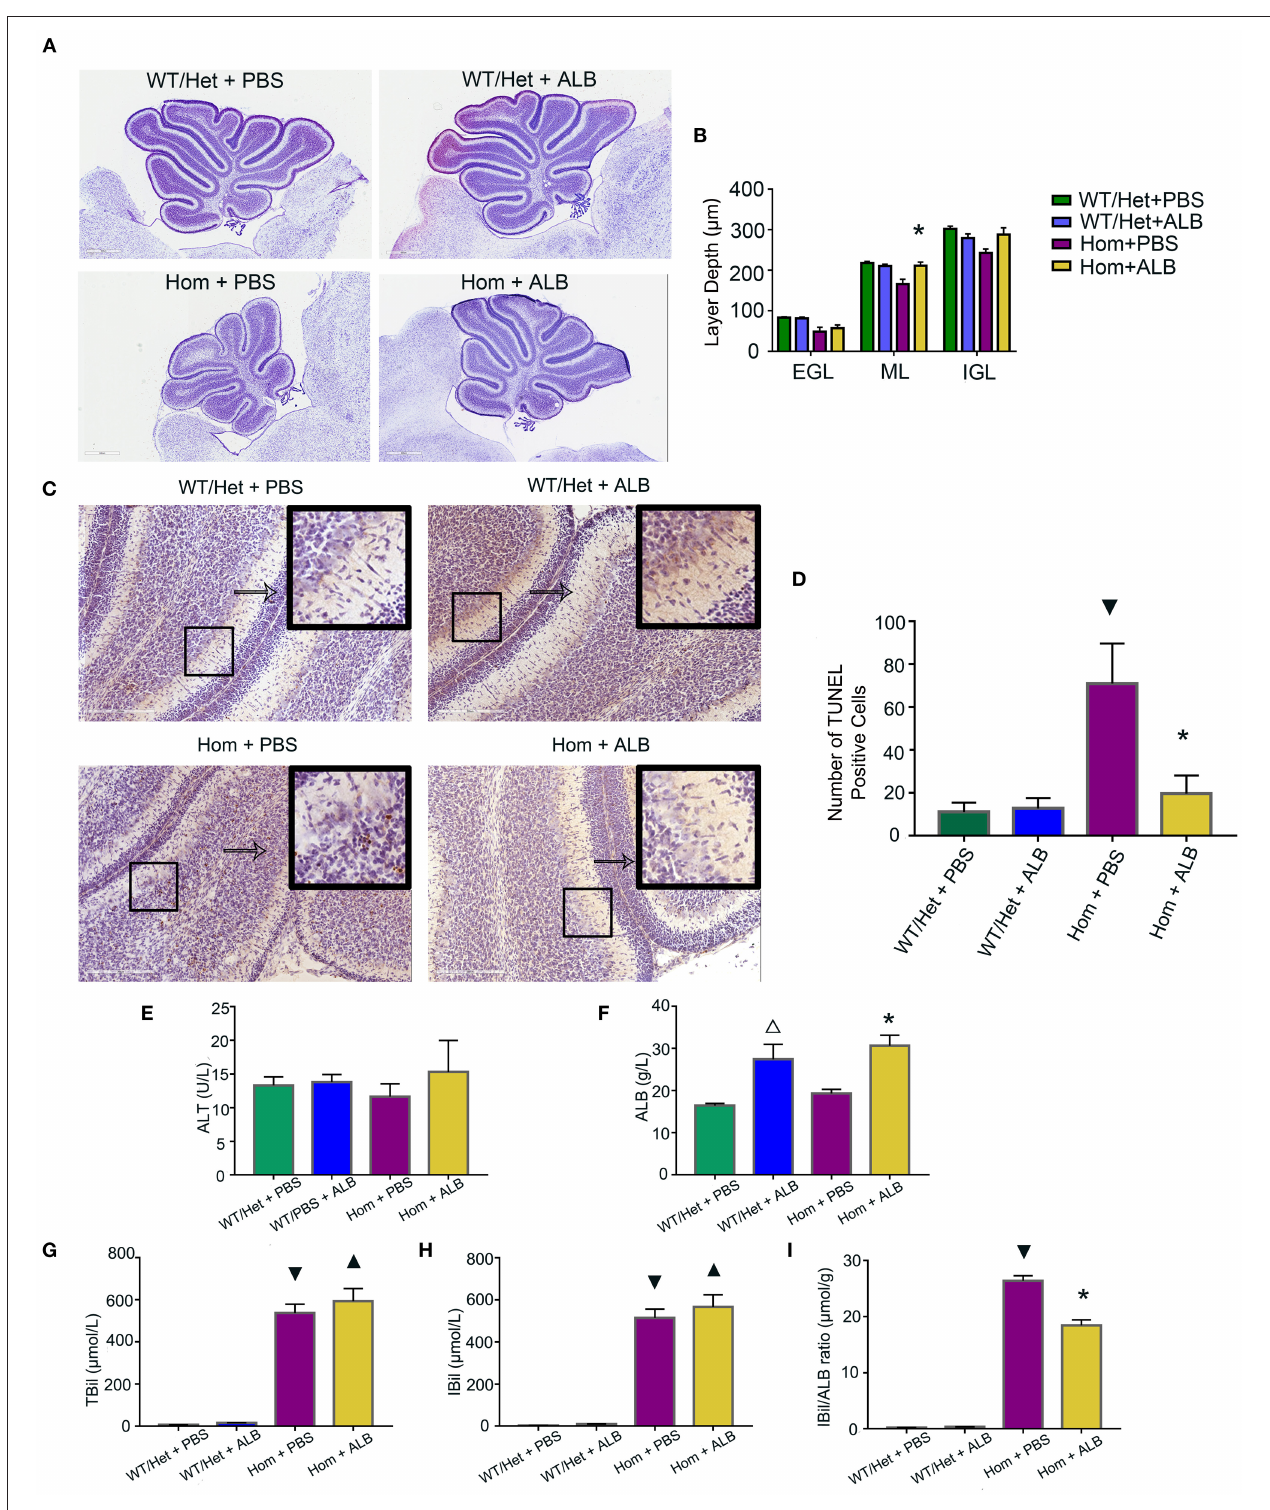
FIGURE 2 | HSA treatment improves cerebellum development and reduces apoptosis of cerebellum cells. (A) Representative images of Nissl staining of the cerebellum of Ugt1 WT/Het and Hom mice that received continuous HSA or withdrawn from the HSA on P8–P9. Scale bar = 600 µ m. (B) One-way ANOVA analysis was conducted among four groups of mice at every layer depth of lobule 4 and lobule 9 ( n = 5–6, respectively). Compared with Hom + PBS mice, HSA treatment for